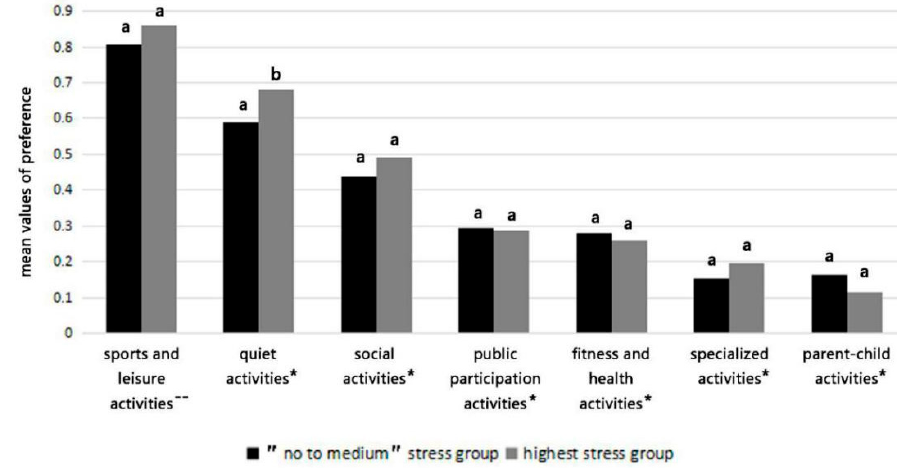
sensory dimensions. ** The significance of mean difference is at the 0.01 level.